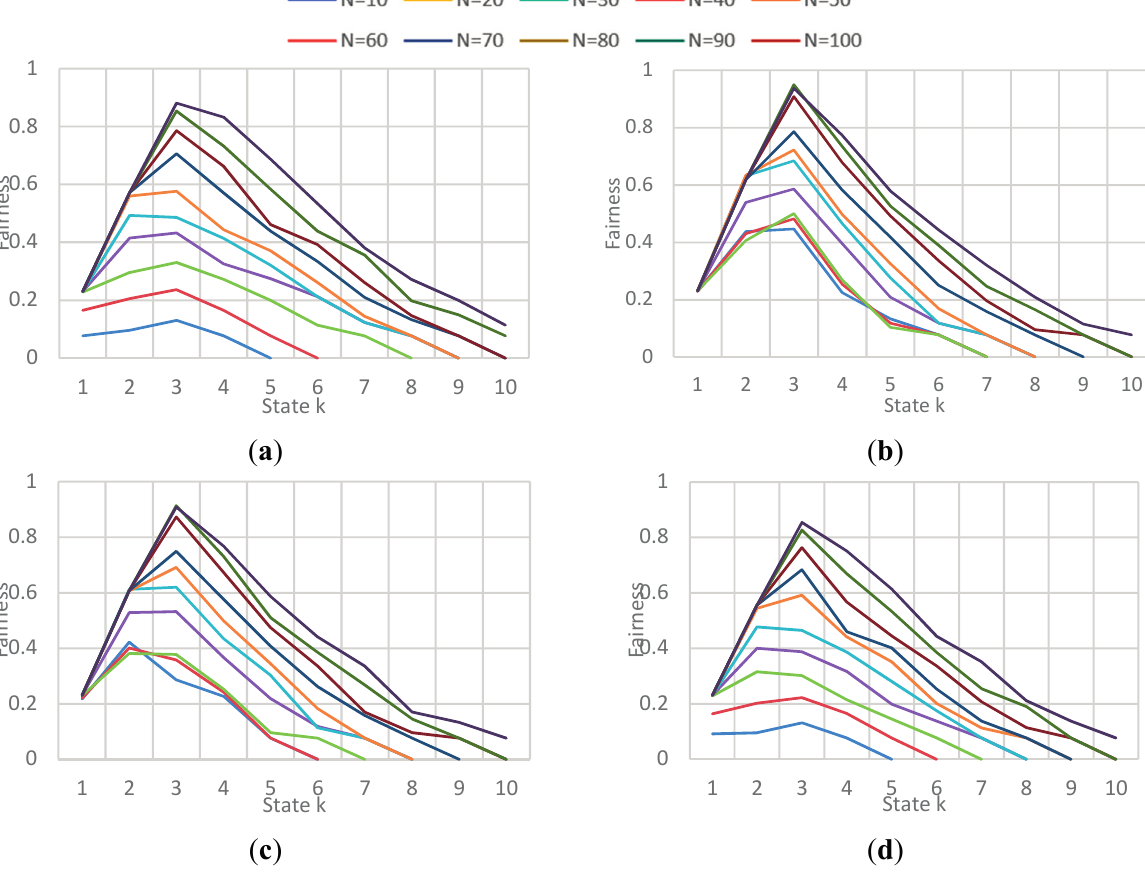
Figure 22. Obtained Fairness in a state k for each N-vehicle set with each implementation. ( a ) Fairness obtained for each N-vehicles with Natural behavior algorithm; ( b ) Fairness obtained for each N-vehicles with Local congestion algorithm; ( c ) Fairness obtained for each N-vehicles with Global Congestion algorithm; ( d ) Fairness obtained for each N-vehicles with Modified Dijkstra